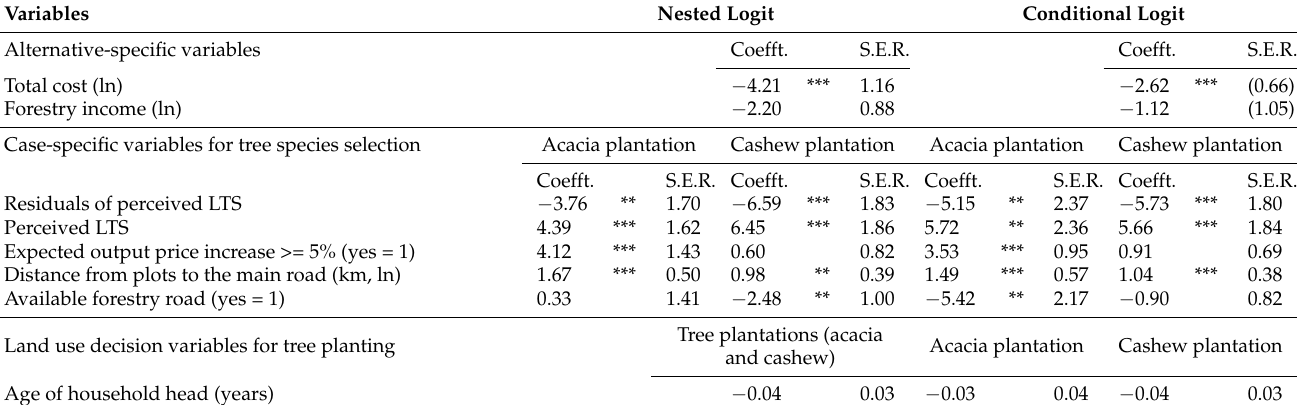
Table A3. Impact of perceived LTS on investment in tree planting using Nested logit and Conditional logit